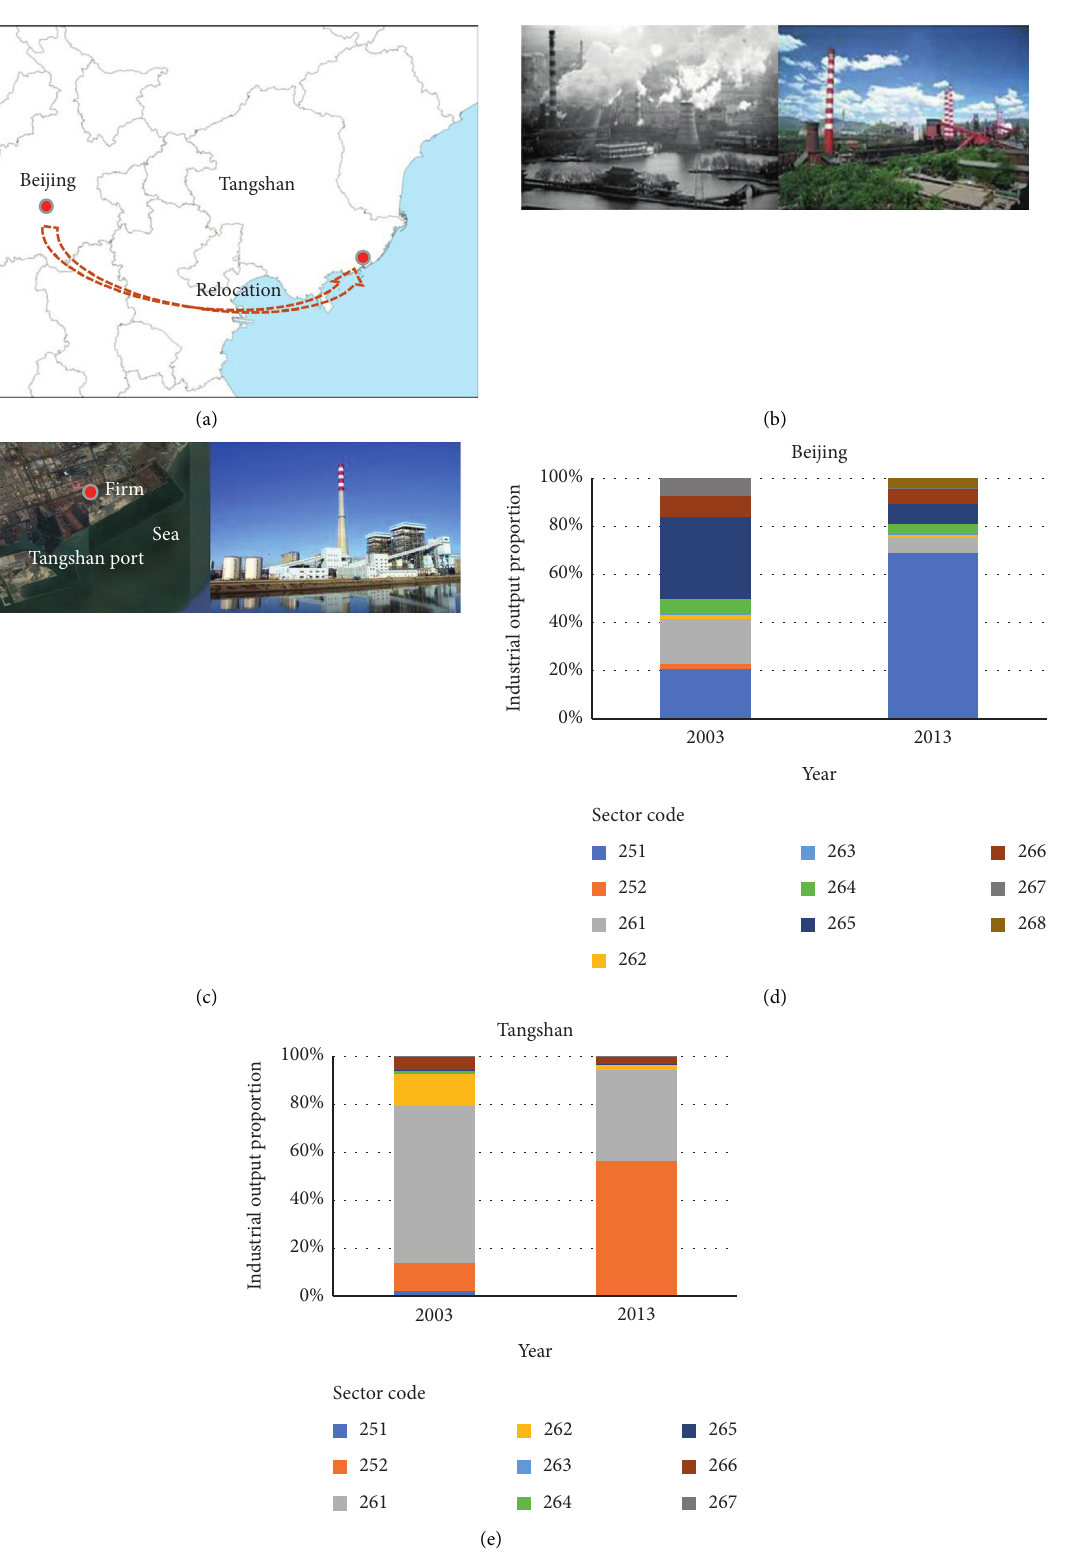
Figure 6: Relocation of chemical companies and changes in industrial structure between Beijing and Tangshan (Beijing-Tangshan Case). (a) Location map before and after firm relocation. (b) Production and shutdown of the firm in Beijing. (c) Location and factory in Tangshan. (d) Industrial output proportion of Beijing’s chemical sectors. (e) Industrial output proportion of Tangshan’s chemical